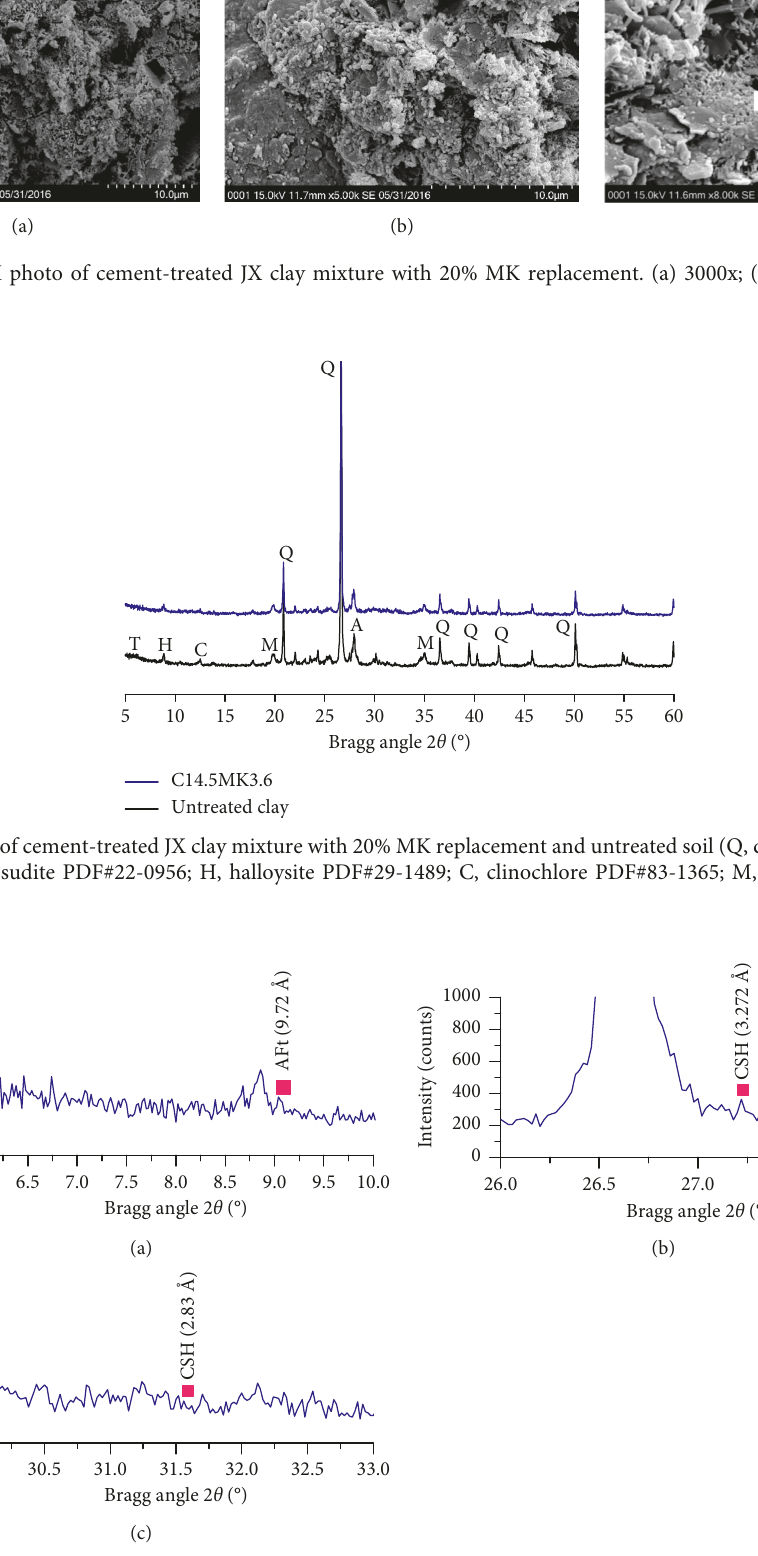
Figure 9: Hydration products identification (AFt PDF#41-1451/PDF#72-0646; CSH PDF#12-0475/PDF#29-0373). (a) Ettringite (AFt); (b) calcium silicate hydrate